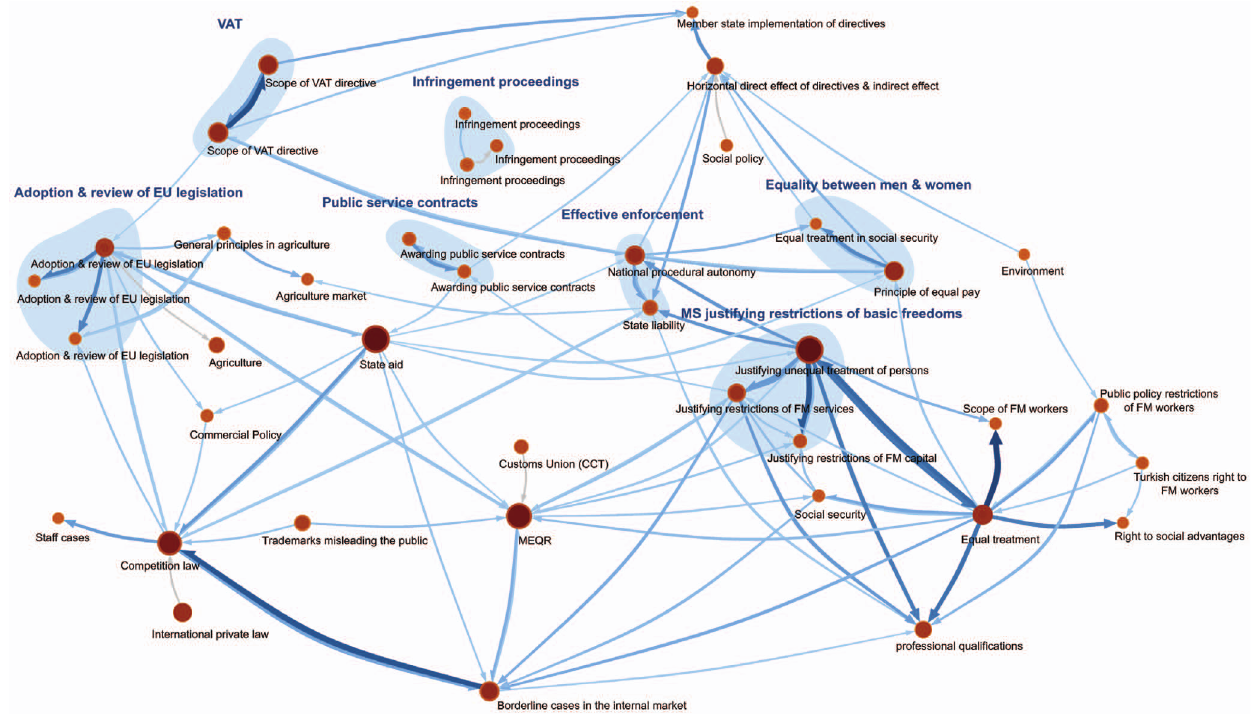
Figure 7. Map of ECJ case law. We partitioned 8,200 court case documents with 32,000 citations. Afterwards, we generated 100 resampled networks using the triangle completion method. By clustering these resampled networks and comparing them to the clustering of the raw network, we can estimate how much support the data provide in partitioning the raw network. The map represents the 40 top modules. Insignificant clusters and their mutually insignificant friends are shaded with blue areas.